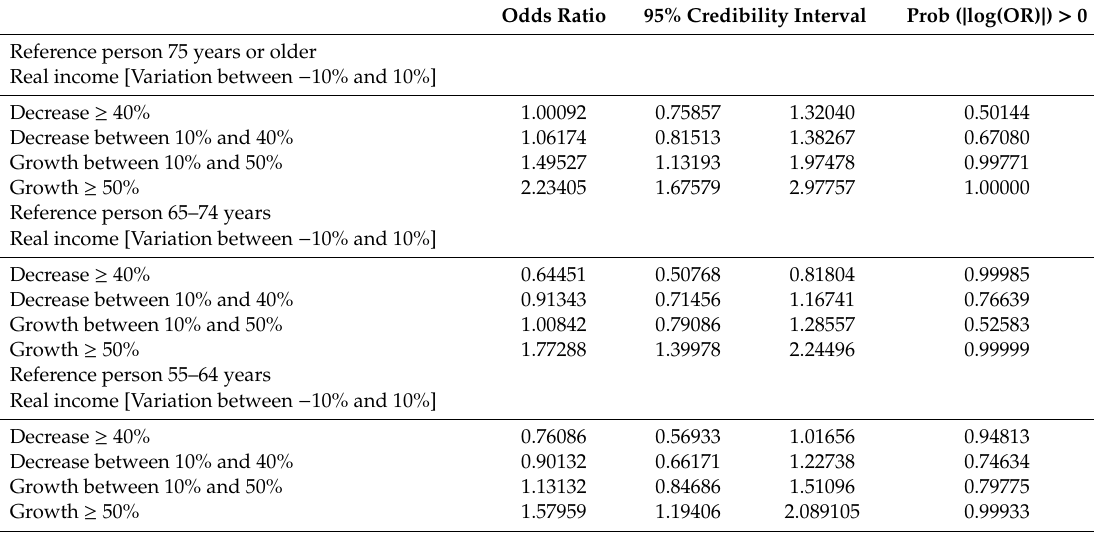
Table15. Associationbetweenthevariationinrealincomeandgoodandverygoodself-perceivedhealth.